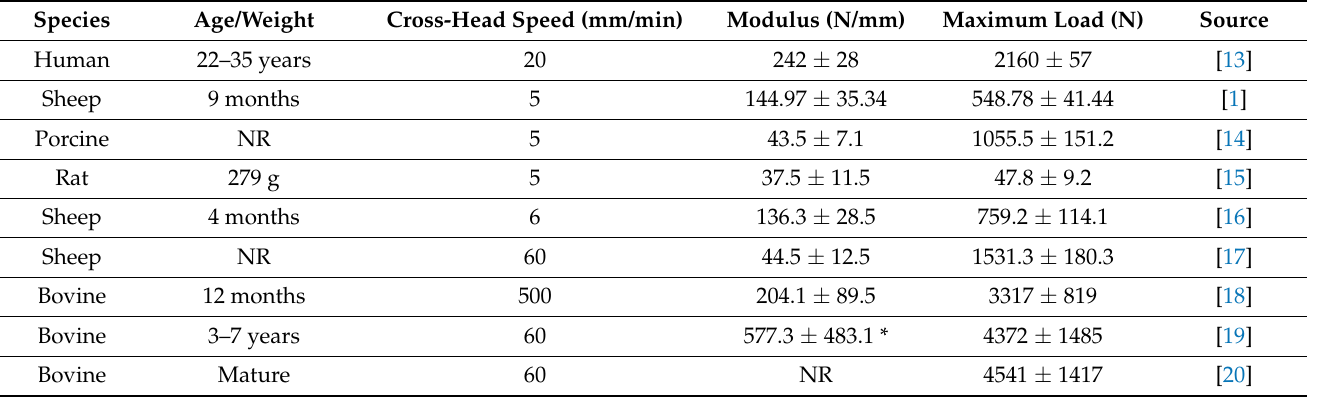
Table 2. Mechanical properties of ACL